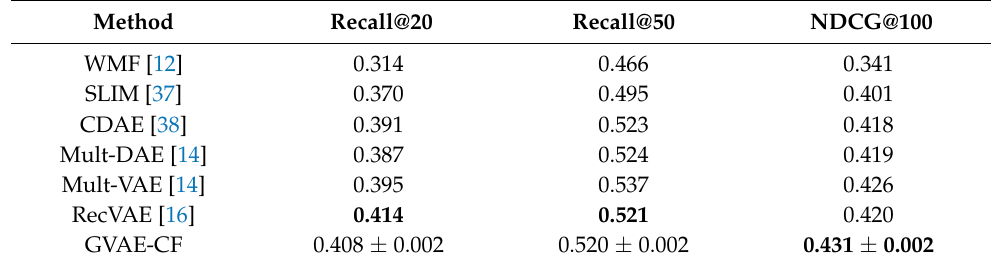
Table 1. Evaluation scores for GVAE-CF and the baseline models using the MovileLens-20M dataset.